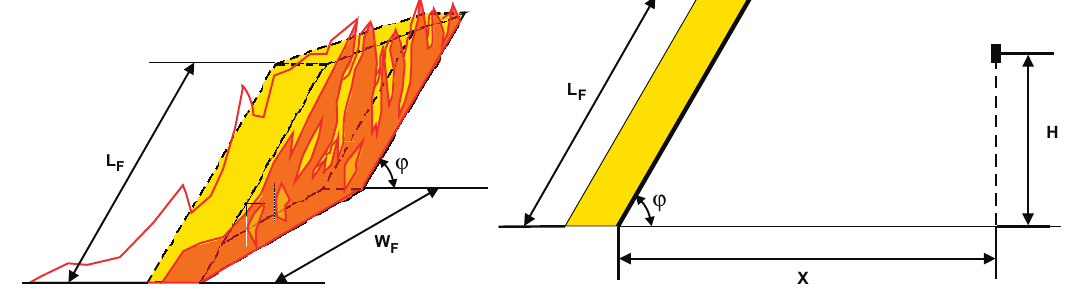
Figure 2. ( Left ) Model of a radiating fire front represented by a cuboid with the width W F of the fire front and the flame height L F . ( Right ) The heat flux will be calculated in the distance x from the fire front and at a point with height H above ground representing the altitude of the